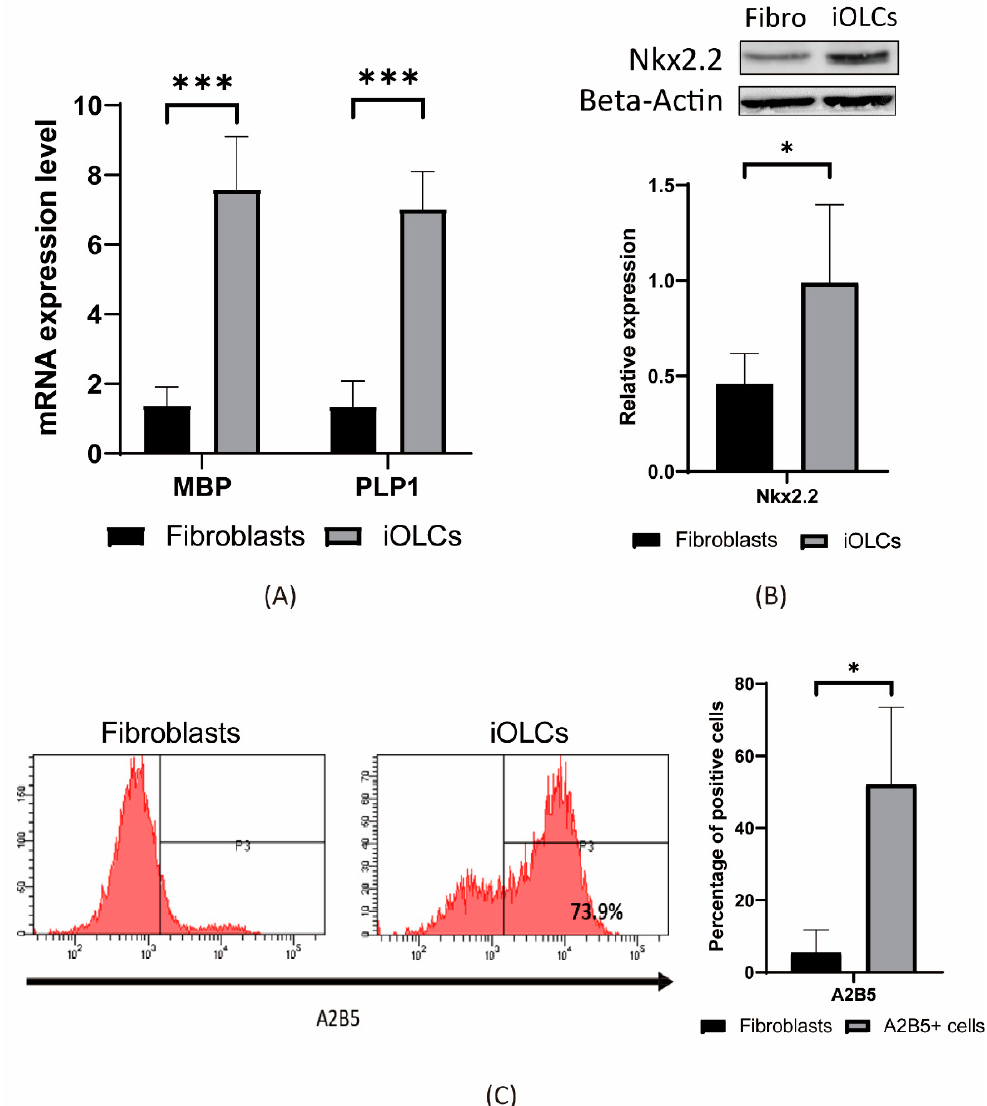
Figure 4. Marker expression in chemically induced oligodendrocyte-like cells. iOLCs were the cells treated with valproic acid, Y27632, SU9516, and forskolin (VYSF). ( A ) The mRNA expression of myelin-forming proteins MBP and PLP1 between the VYSF-treated group (iOLCs) and the solvent control group was confirmed by quantitative real-time polymerase chain reaction (qRT-PCR). Data are presented as mean ± standard deviation. ( n = 3). GAPDH was used as reference gene. Significant differences were determined using Student’s t -test, * p < 0.05, ** p < 0.005, *** p < 0.001. ( B ) Western blot analysis showing transcription factor Nkx2.2 protein up-regulation in the VYSF-treated group (iOLCs). Quantification of Western blot data is shown at the bottom. Data are presented as mean ± standard deviation. ( n = 5). β -actin was used as an internal control. Significant differences were determined using Student’s t -test, * p < 0.05. ( C ) Flow cytometry was performed to quantify A2B5+ cells of chemical cocktail VYSF-treated fibroblasts (iOLCs). In the chemically treated group, A2B5+ was detectable in an average of 50% of the cells. Data are presented as mean ± standard deviation. ( n = 3). Significant differences were determined using Student’s t -test, * p <